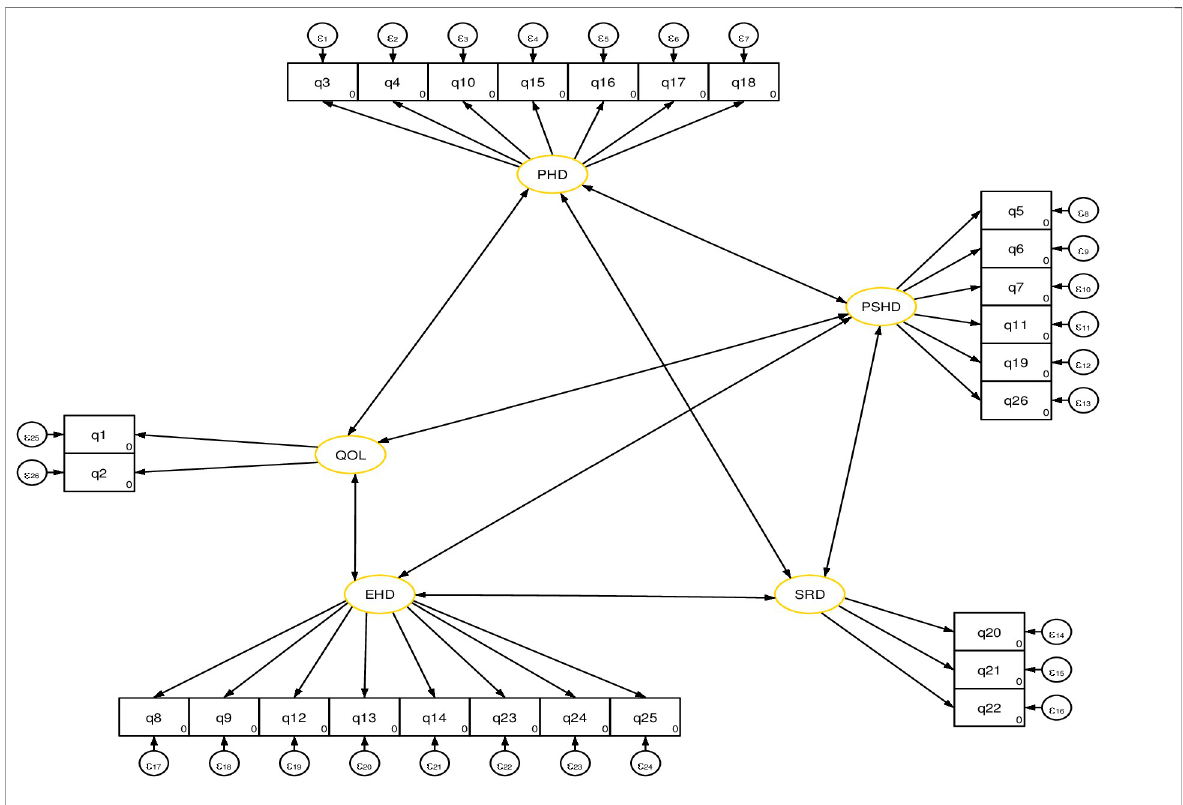
Fig 2. Theoretical model of quality-of-life measurement (S1